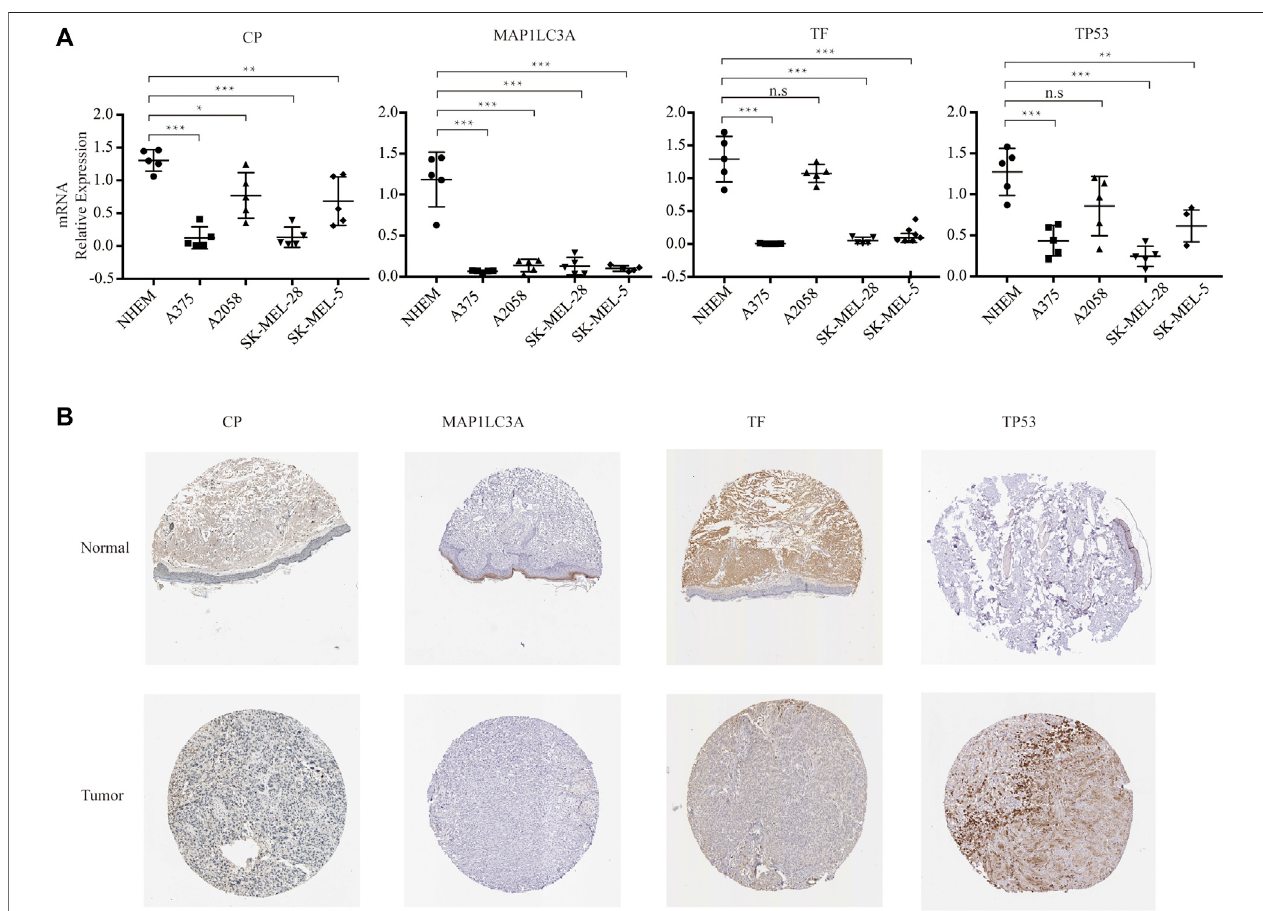
FIGURE8| Experimentalveri fi cation. (A) RNAexpressionofthefourgenesinmultistrainmelanomacelllinesandnormalhumanepidermalmelanocytes. (B) Protein expression of the four genes in normal and melanoma tissue from Human Protein Atlas immunohistochemistry.